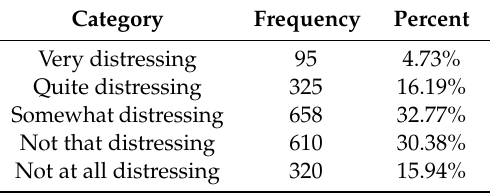
Table 3. Nightmare distress ( n = 2008).